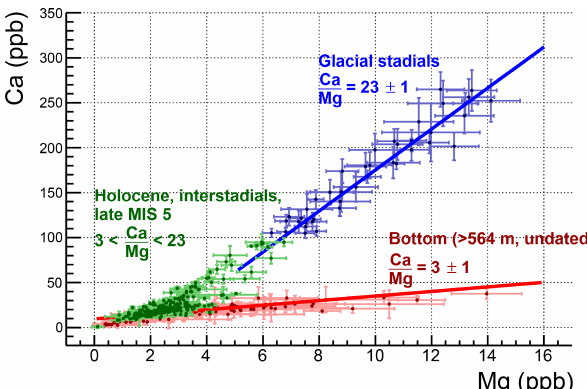
Figure 3. Calcium and magnesium concentrations in the RECAP core. Samples with high ( > 100ppb) calcium concentrations are drawn in blue. The red samples of the bottom 22m (562–584m depth) are not dated but may consist of Eemian ice (see main text). All others samples are drawn in green. The Ca / Mg ratio varies be- tween 3 ± 1 (Asian dust) and 23 ± 1 (gypsum and/or excess of car- bonate). The seawater ratio (Ca / Na) m = 0 . 32 cannot be